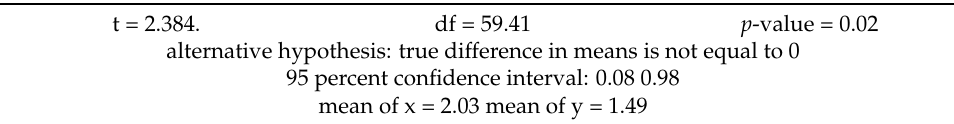
Table 1. The empirical results of Welch two-sample t